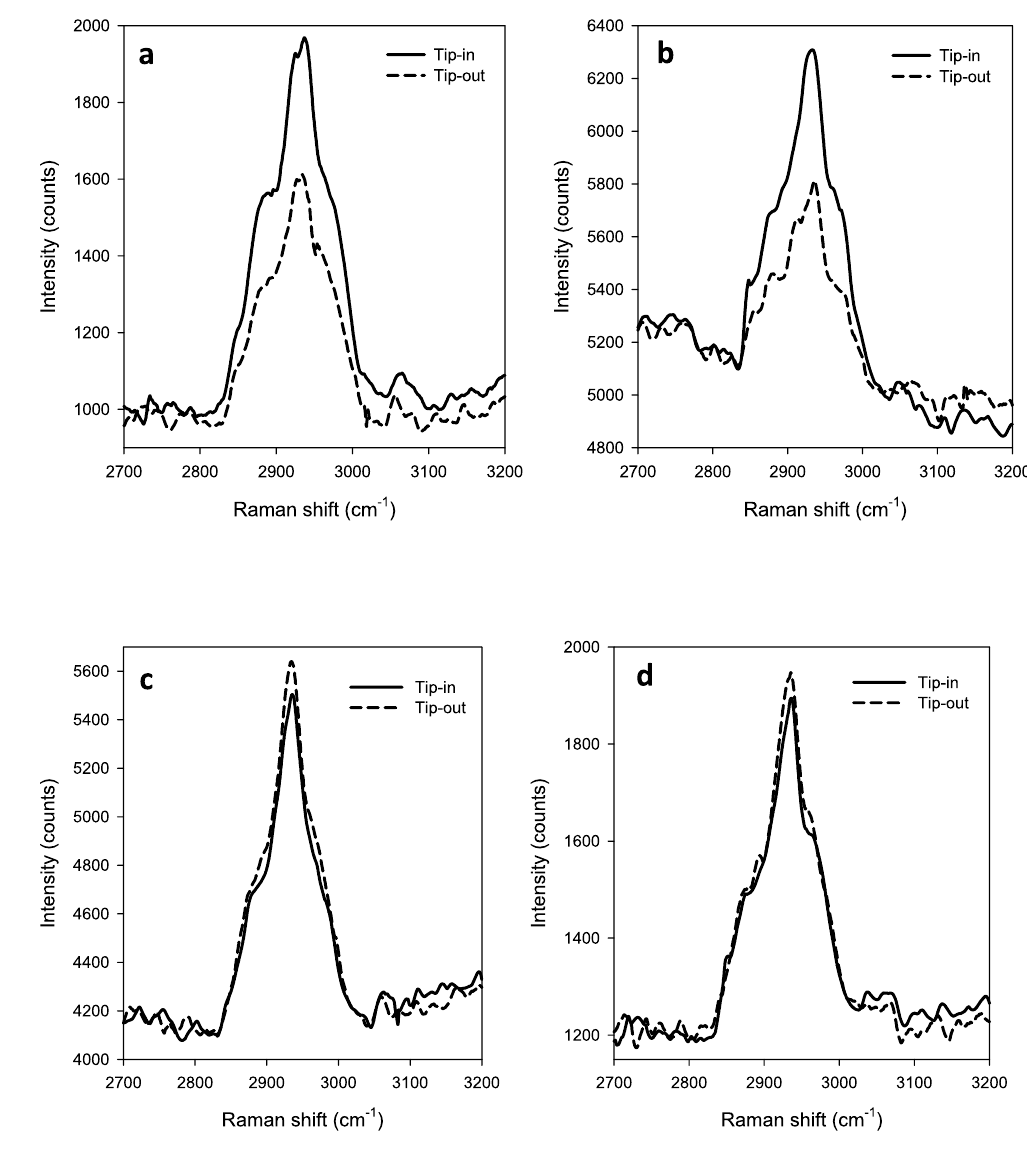
Figure 3. A comparison between Tip-in (solid lines) and Tip-out (dashed lines) for Gram negative and Gram positive bacteria samples. For Gram negative bacteria: ( a ) Escherichia coli and ( b ) Pseudomonas aeruginosa were measured. For Gram positive bacteria: ( c ) Bacillus subtilis and ( d ) Staphylococcus aureus were